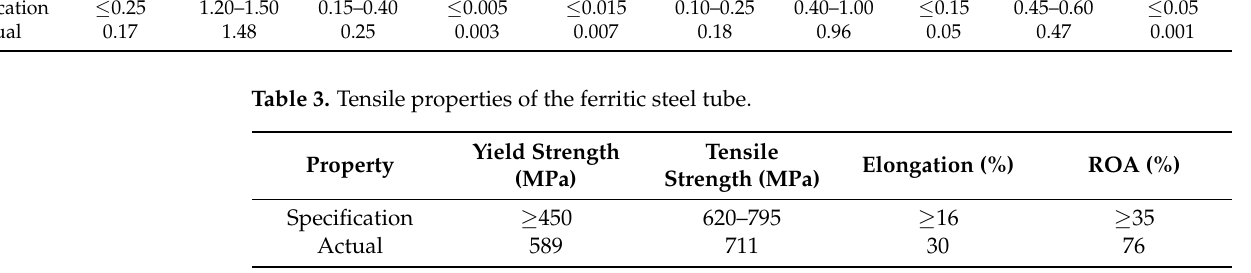
Table 2. Chemical composition of the ferritic steel tube.